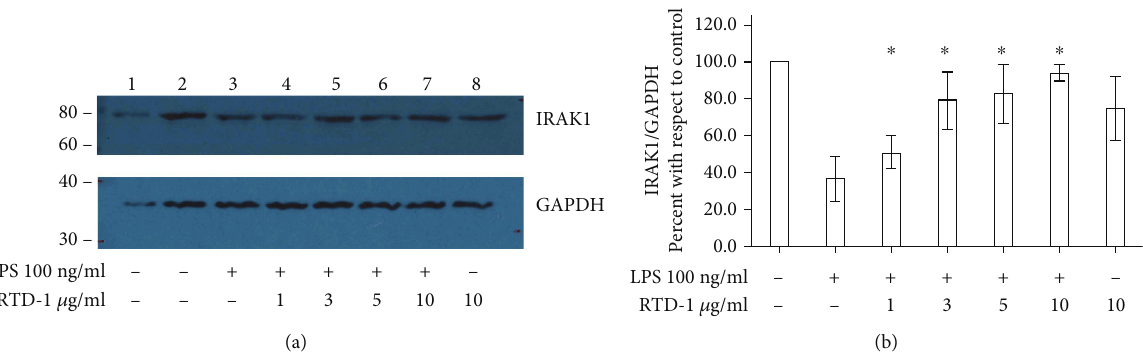
Figure 3: RTD-1 stabilizes IRAK1 in LPS-stimulated cells. THP-1 cells were treated with 100 ng/ml LPS in the presence of RTD-1 for 20 h as shown. (a) Extracts from cells were analyzed by western blotting experiments using the anti-IRAK1 and anti-GAPDH antibodies. A representative western blot from three experiments is shown. The sample in lane 1 is the same as that in control lane 2 but has 50% less protein. The numerals at the left indicate molecular weights in kDa. (b) Quanti fi cation of western blots from 3 experiments. ∗ P < 0 : 05 compared to LPS treatment, two-tailed, paired t test.